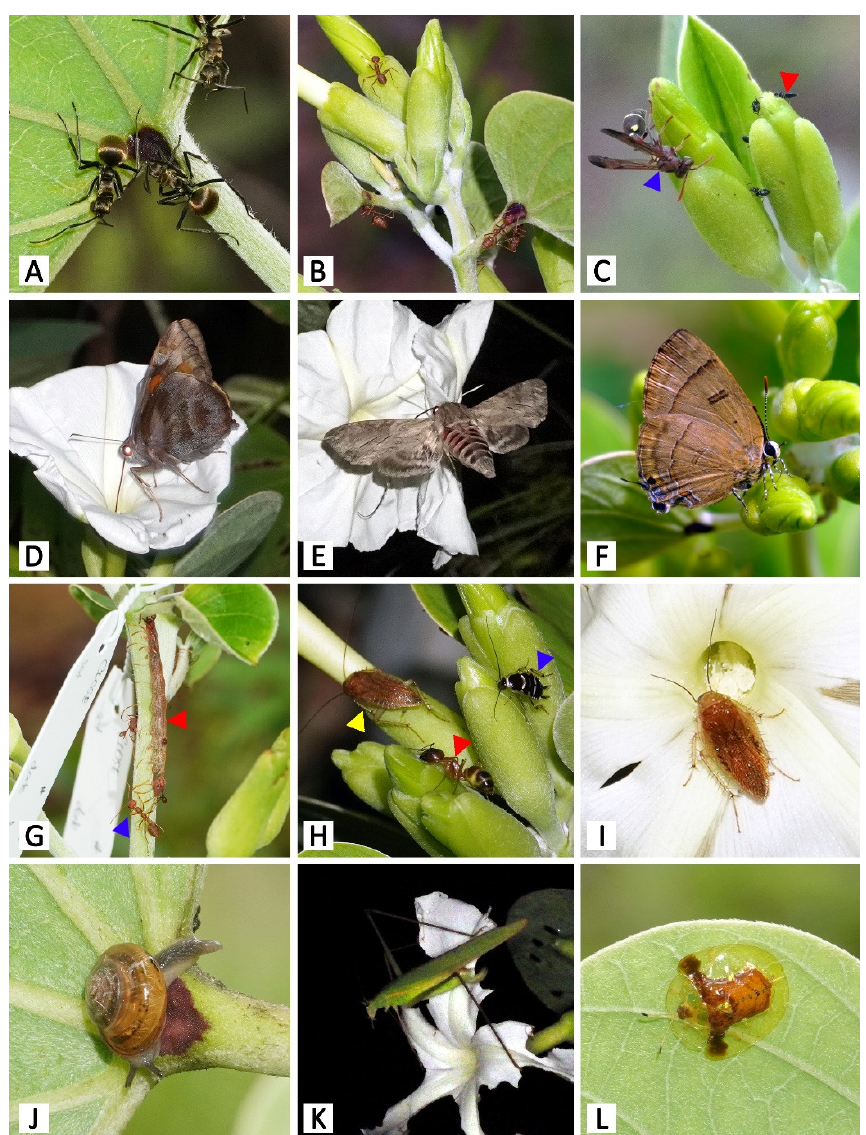
Figure 11. Animal visitors of Rivea ornata (hv: herbivore, pr: potential protector, ec: exudate consumer, po: potential pollinator). ( A ) Polyrhachis proxima (pr) on petiolar nectaries. ( B ) Oecophylla amaragdina (pr) on calyx and petiolar nectaries. ( C ) Ropalidia sp. (ec; blue arrowhead) and Crematogaster sp. (pr; red arrowhead) visiting calyces. ( D ) Gangara thyrsis (po) visiting a flower. ( E ) Agrius convolvuli (po) visiting a flower. ( F ) Rapala dieneces dieneces (ec) visiting a calyx. ( G ) Caterpillar of Homodes sp. (hv; red arrowhead) on a branch, undisturbed by Oecophylla amaragdina (pr; blue arrowhead). ( H ) Balta sp. (ec; yellow arrowhead), Lobopterella dimidiatipes (ec; blue arrowhead), and Camponotus sp. (pr; red arrowhead) on calyces. ( I ) Balta sp. (po) visiting a flower; note the pollen grains on its antennae. ( J ) Unidentified Helicinan snail (ec) on a petiolar nectary. ( K ) Unidentified katydid (hv) consuming the corolla of a flower. ( L ) Aspidimorpha sp. (hv) on a leaf.